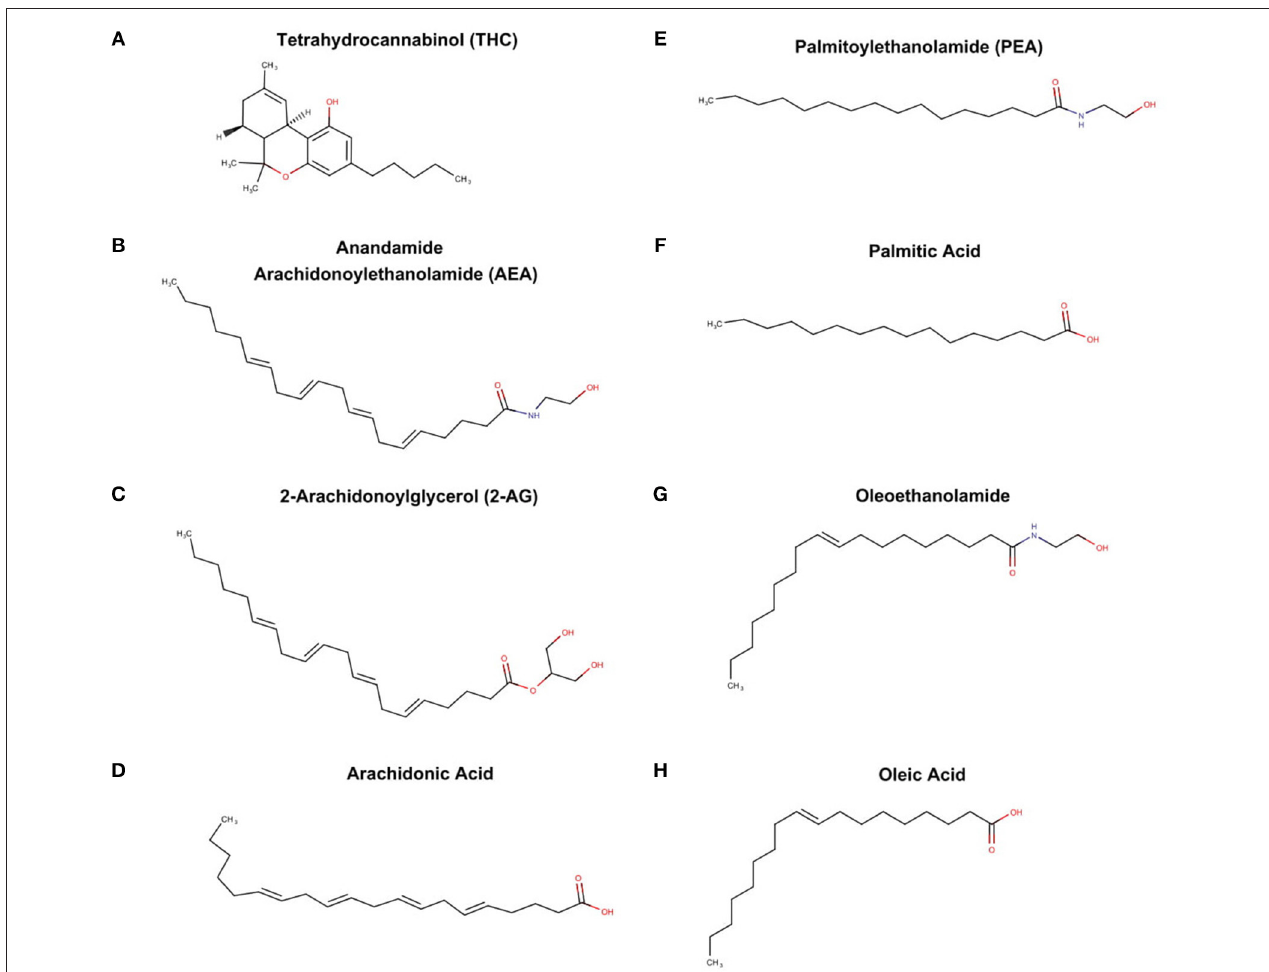
FIGURE 4 | THC from marijuana plant, endocannabinoid, and endocannabinoid-like agents (A) tetrahydrocannabinoid (THC), (B) anandamide arachidonoylethanolamide (AEA), (C) 2-arachidonoylglycerol (2-AG), (D) archidonic acid, (E) palmitoylethanolamide, (F) palmitic acid, (G) oleoethanolamide, and oleic acid (H)